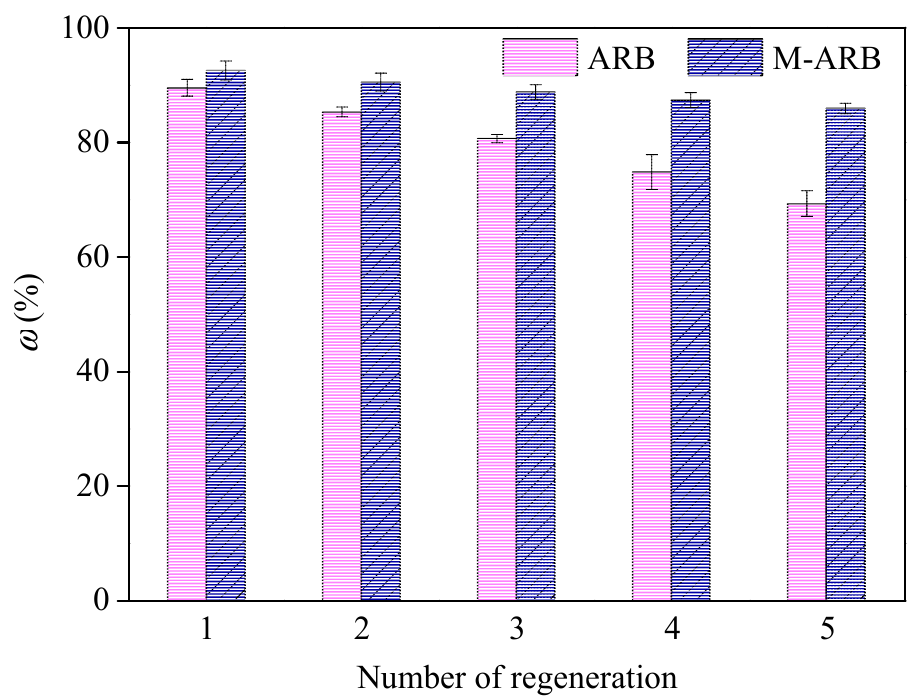
Figure 13. Regeneration performance of ARB and M-ARB for MB adsorption.